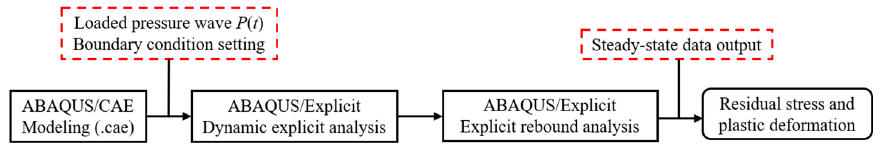
Figure 5. LSP simulation process.